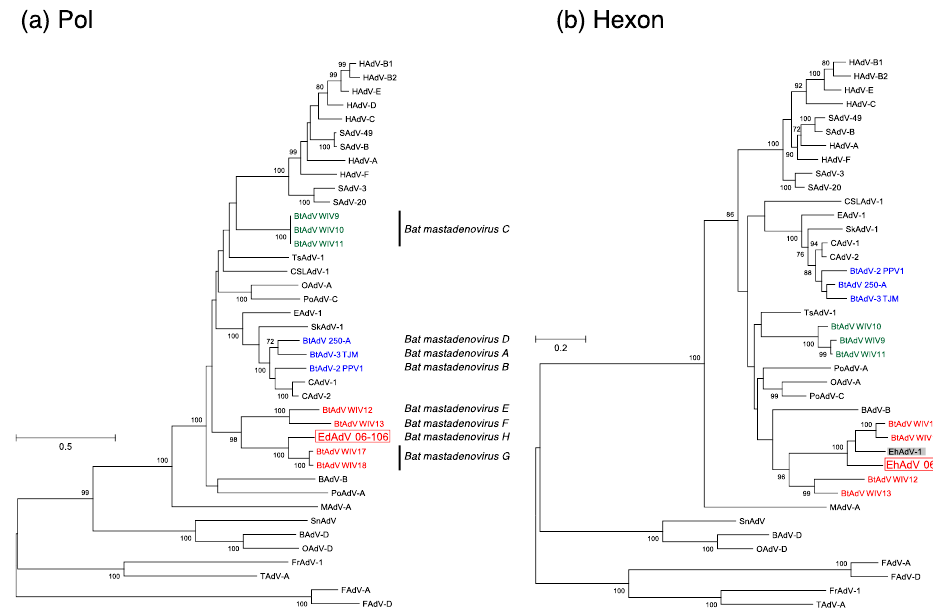
Figure 4. Maximum-likelihood phylogenetic trees based on the predicted amino acid sequences for DNA polymerase (pol) ( a ) and hexon ( b ). The dendrograms of pol and hexon were constructed using an LG (Le and Gascuel, 2008) model with gamma distribution and invariable sites with the highest log likelihood (−27,885.86709), and an LG model with gamma distribution with the highest log likelihood (−20,968.7769), respectively. The percentages at nodes are bootstrap probabilities calculated using 1000 replicates and indicate bootstrap supports >70%. Bat adenoviruses in groups 1 to 3 in Figure 3 are shown in colors. Open rectangles and gray-shaded rectangle indicate EhAdV 06-106 and EhAdV 1 isolated in Ghana, respectively. Bars indicate the number of substitutions per site. The sequences listed in Table S1 and EhAdV 1 (GenBank accession number: JX885602) were